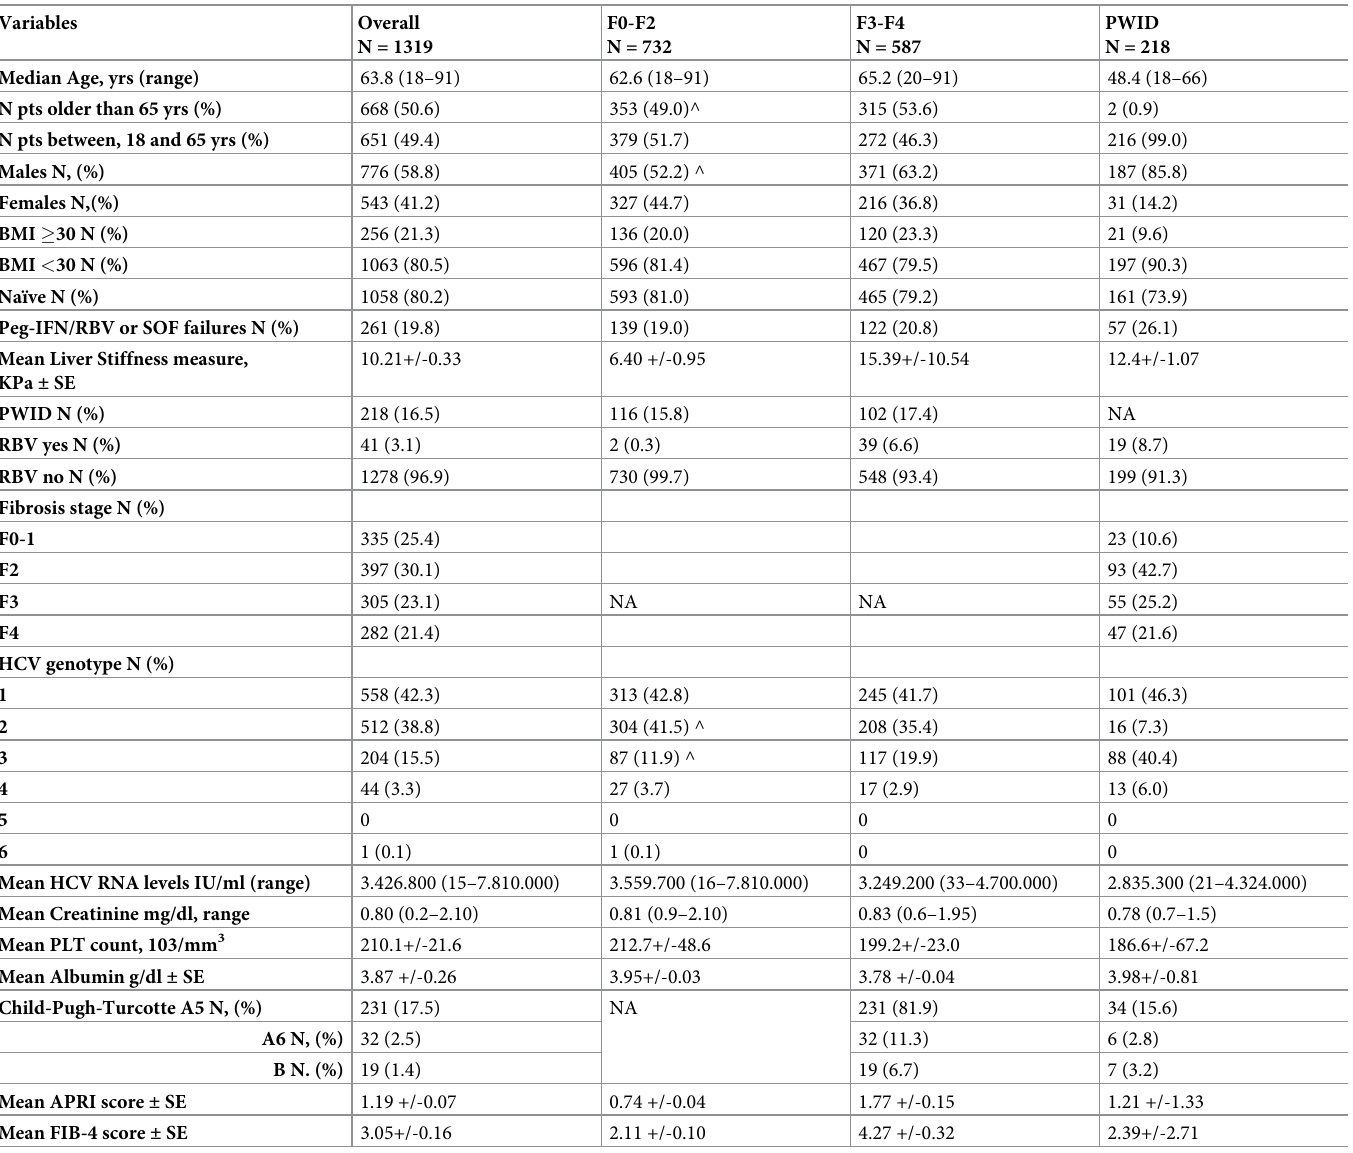
Table 1. Baseline characteristics of